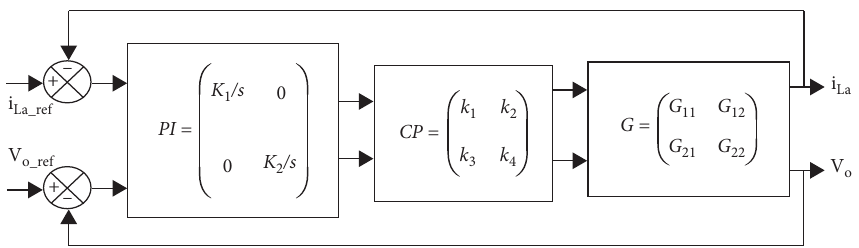
Figure 8: Scheme of the closed loop in the frst mode.